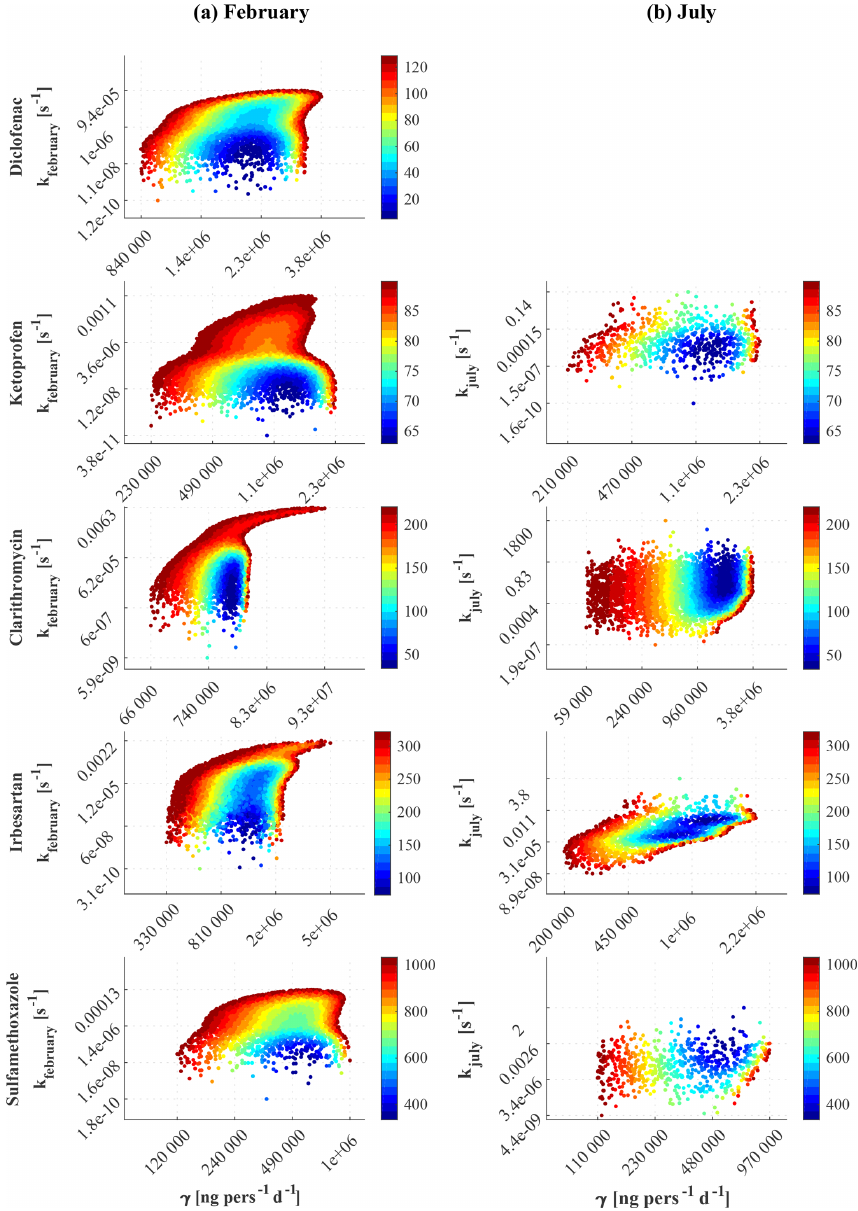
Figure 4. Objective function L , given by Eq. (19), as a function of the model’s parameters for the five selected compounds. The left and right columns refer to winter and summer campaigns, respectively. Each dot at the position sampled by the Latin hypercube technique assumes the color corresponding to the scale for L shown on the right of each panel. For clarity, pairs of k and γ resulting in values of L larger than the 0.1 quantile are not